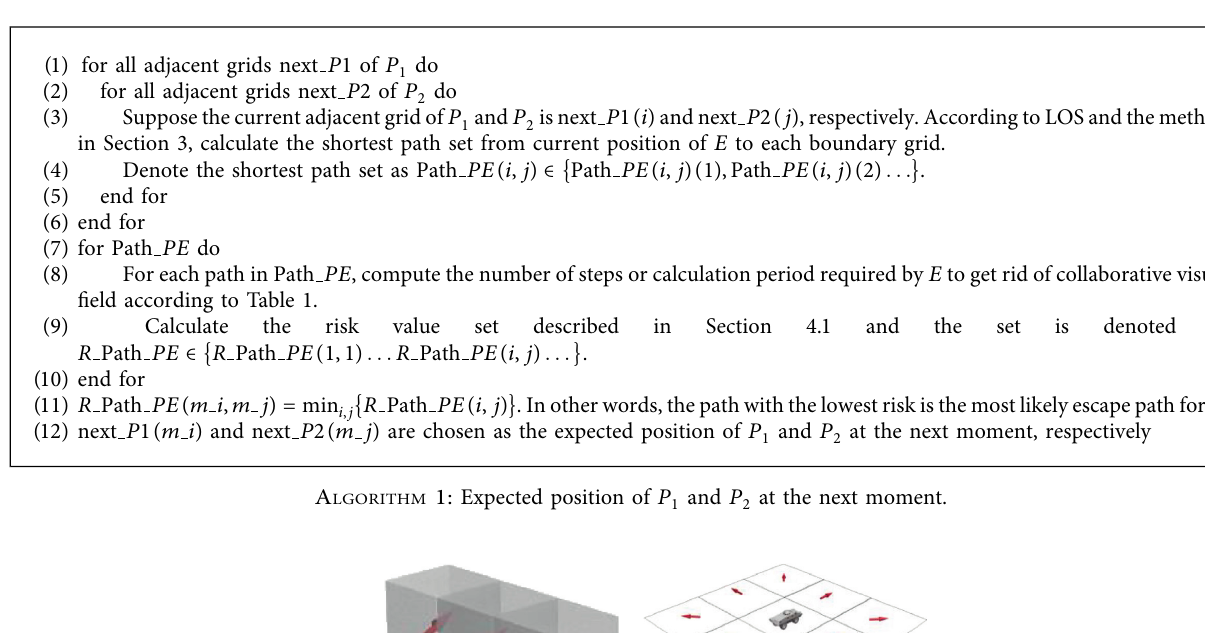
. (b) Adjacent grid of P 1